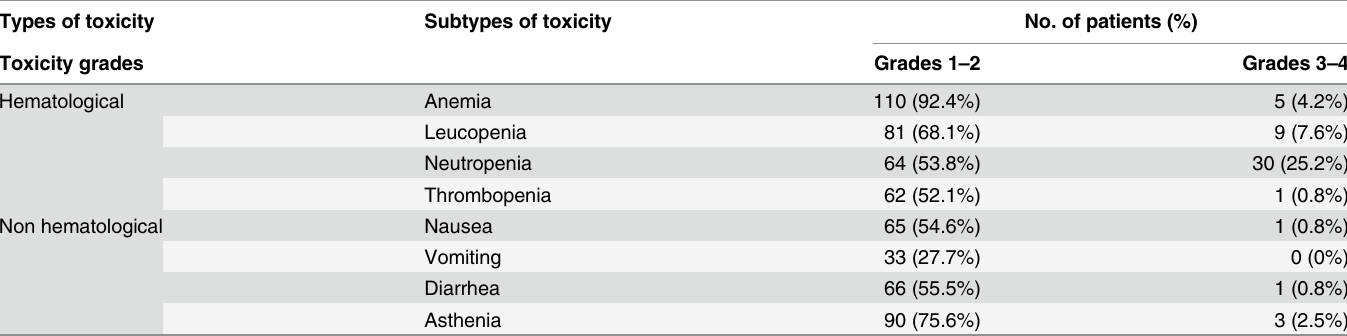
Table 2. Maximal gemcitabine-caused toxicities over treatment.